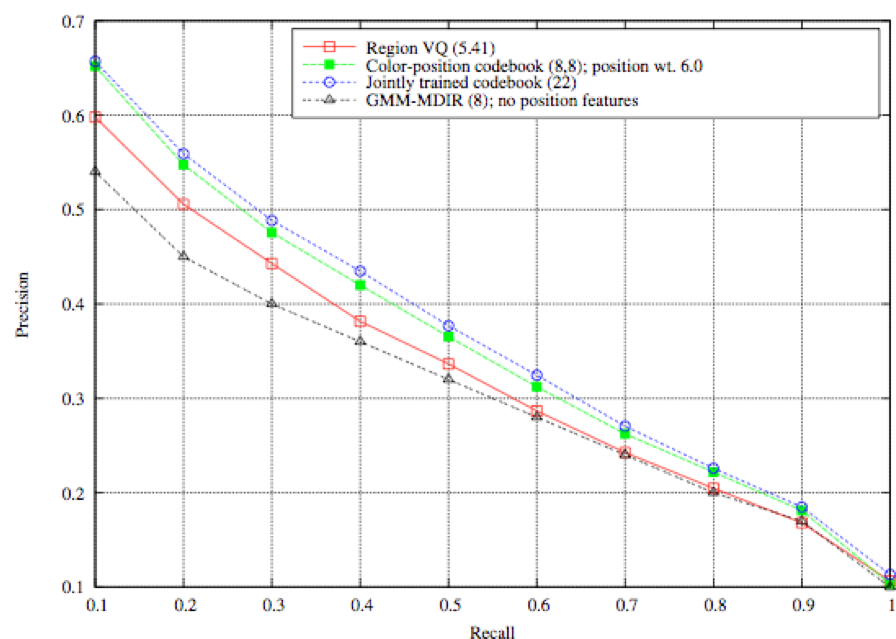
Figure 8. Region VQ compared to previous